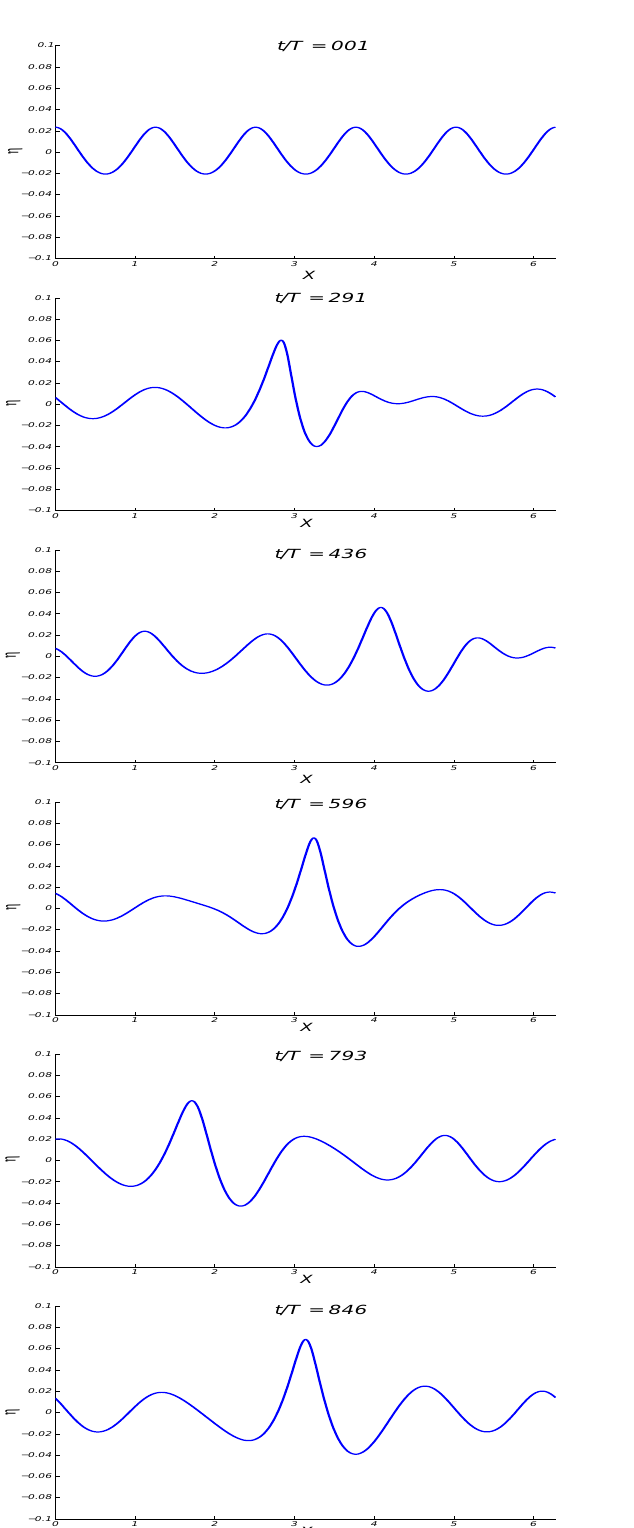
Fig. 4. Surface wave profiles at different times, obtained while propagating initial condition corresponding to seeded case with ( 𝒜 , Ω) = (4 , 0 . 61) . From top to bottom 𝑡/𝑇 = 1 , 410 , 496 , 601 , 676 , 885 .